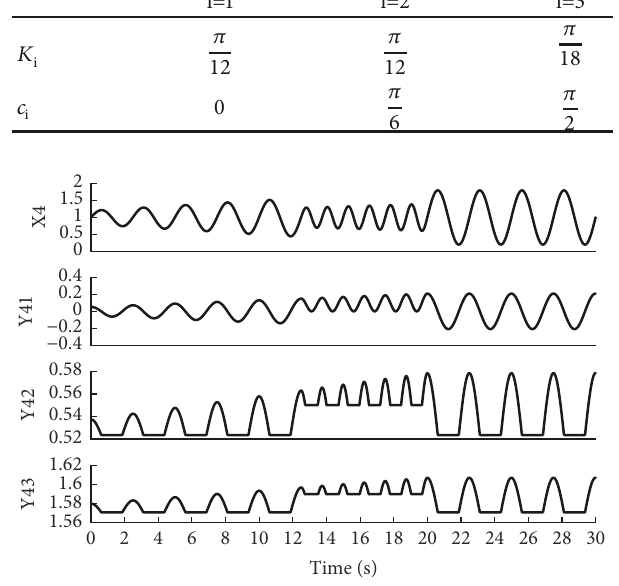
Figure 19: CPG and angular control signals of leg